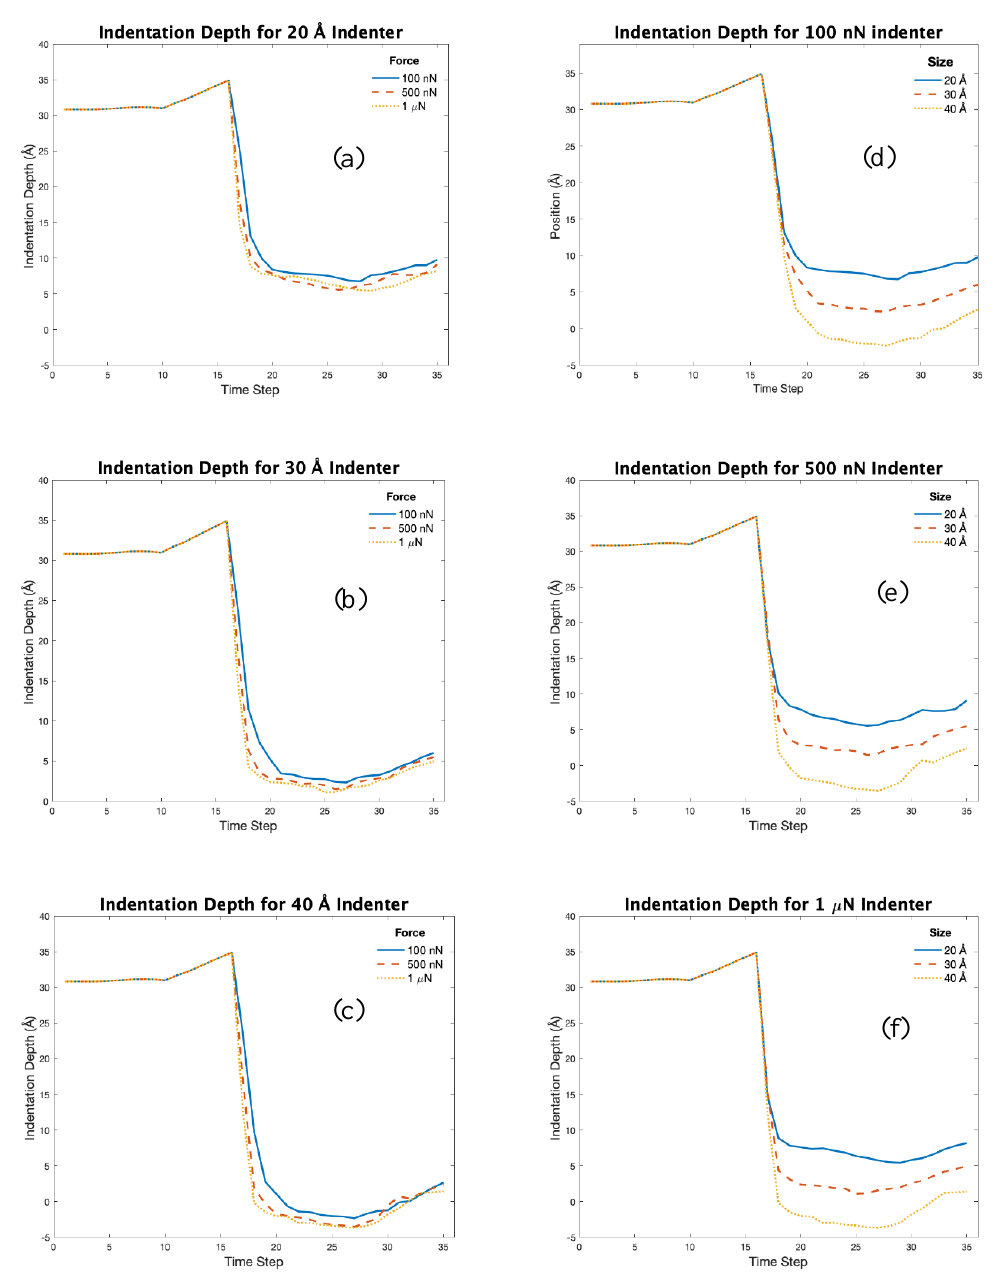
Figure 5. Indentation comparison based on indenter size: ( a ) 20, ( b ) 30, and ( c ) 40 Å and indenter force: ( d ) 100 nN, ( e ) 500 nN, and ( f ) 1 µN.